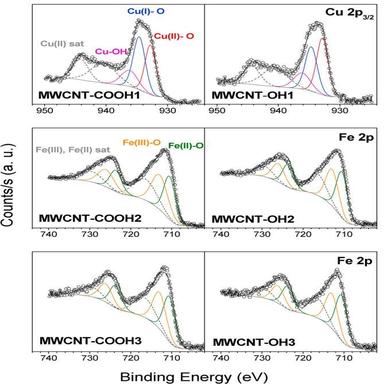
Cu 2p3/2 (top row) and Fe 2p XPS (middle and bottom rows) spectra (dots) showing the chemical components (colored lines) and satellites (gray dashed lines).